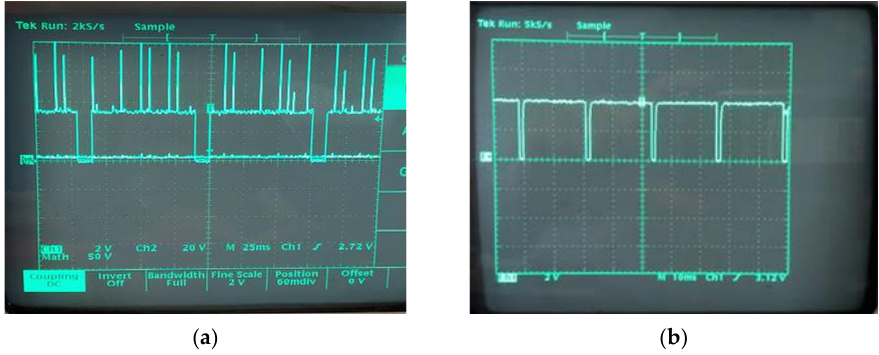
Figure 7. The oscilloscope’s display: ( a ) before the installation of the Zener diode; ( b ) after the installation of the Zener diode.